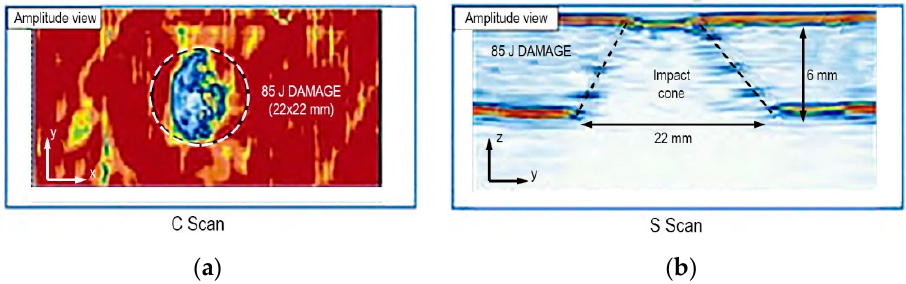
Figure 31. Low velocity impact damage: ( a ) typical peanut shape in the plane of the plate; ( b ) conical distribution of delamination through the thickness.